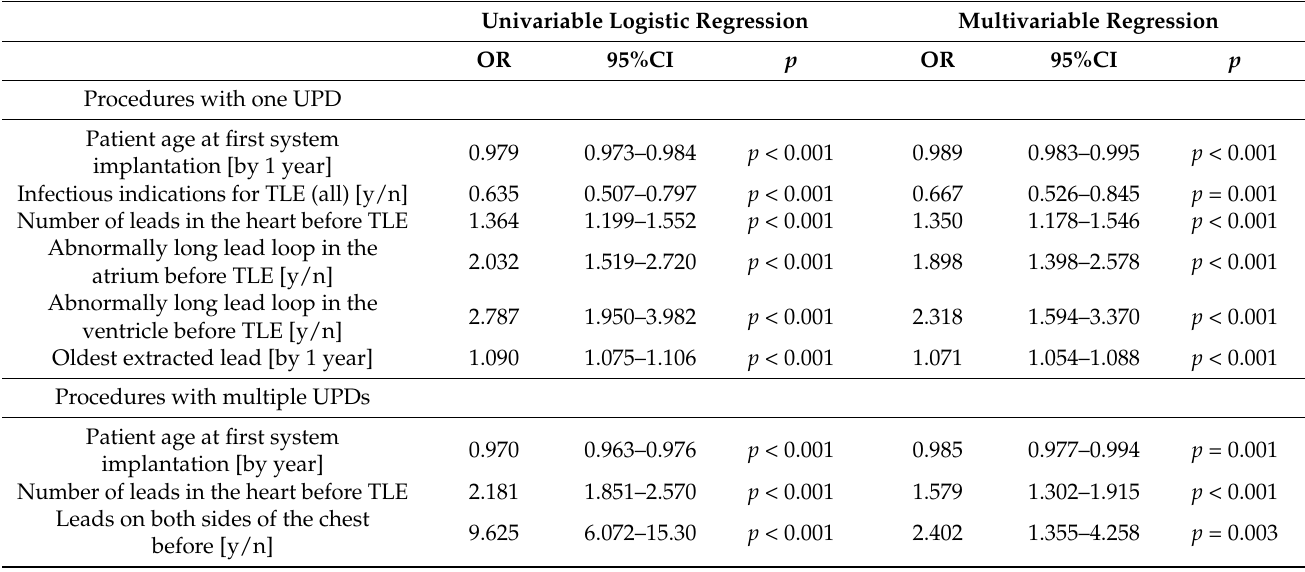
Prognostic factors for the occurrence of UPDs—results of stepwise multivariable regression